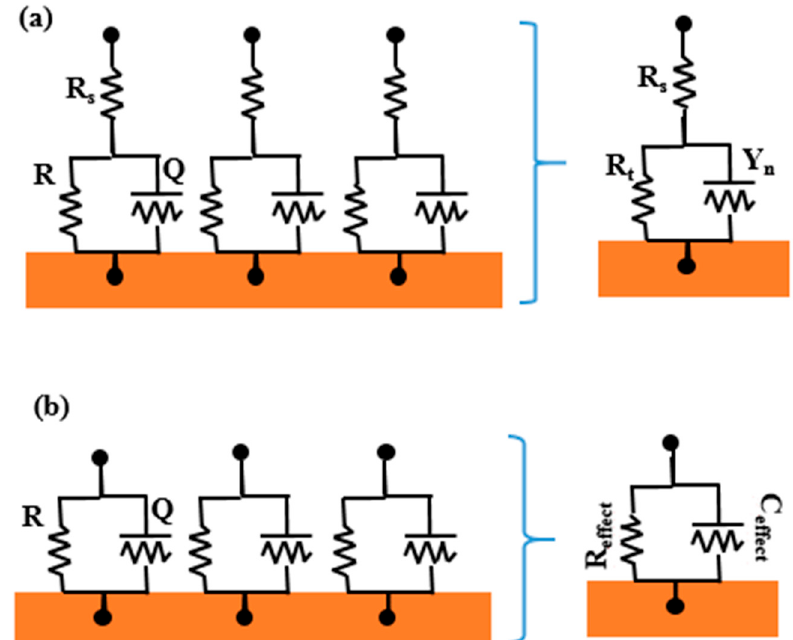
Figure 9. Schematic representation of a surface distribution of time constants: ( a ) distribution of time constants in the presence of an Ohm resistance resulting in a distributed time constant behavior that, for an appropriate time constant distribution, may be expressed as a constant phase angle component (CPE); ( b ) distribution of time constants in the absence of an Ohm resistance resulting in an effective RC (resistance-capacitance) behavior. The admittance Y shown in ( a ) includes the local interfacial and Ohm contributions [91].